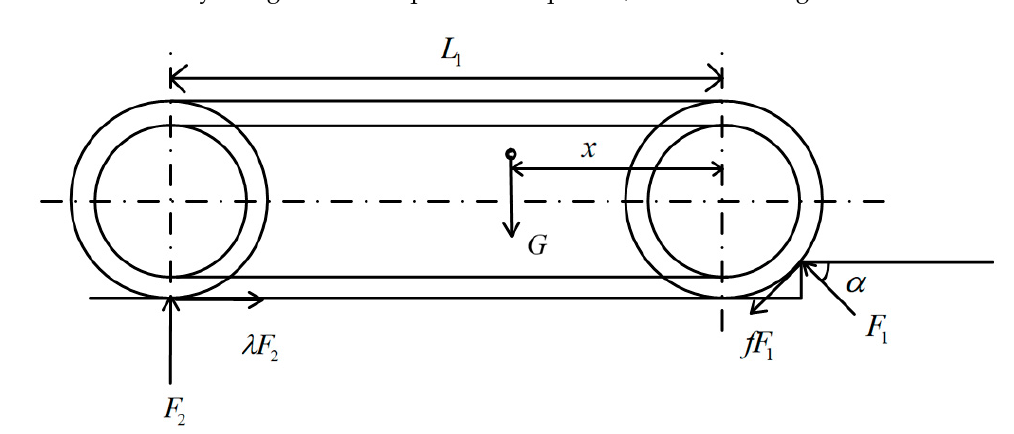
Figure 5. The trajectory of the robot’s center of mass. Therefore, the trajectory of the robot’s center of mass is a circle with ( m 1 L + m 2 L 1 as the center and r = m 2 L 2 as the radius. m 1 + m 2 1.